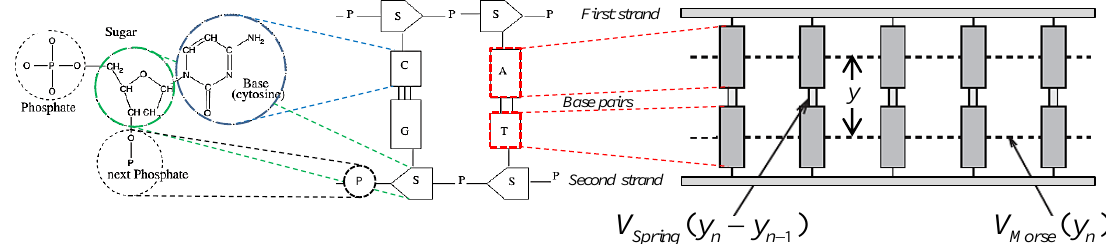
Figure 1. The illustration of nucleotide chemical compounds constructs the mathematical model of DNA double strands [33] DNA has a structure whose outer side contains sugar and phosphate, forming two long strands of the top and bottom (Figure 1). The possible combination between the two pairs allowed A-T and G-C bases. The sugar-phosphate chemical bonds are more rigid than the hydrogen bonds of the two bases [31]. When DNA undergoes vibrations, assuming the n base pair is stretched, the perturbation will be transmitted to the nearest neighbor to n + 1 and n – 1, so on for the other base pairs. The perturbation in a realistic system is the interaction between DNA and other biomolecules such as